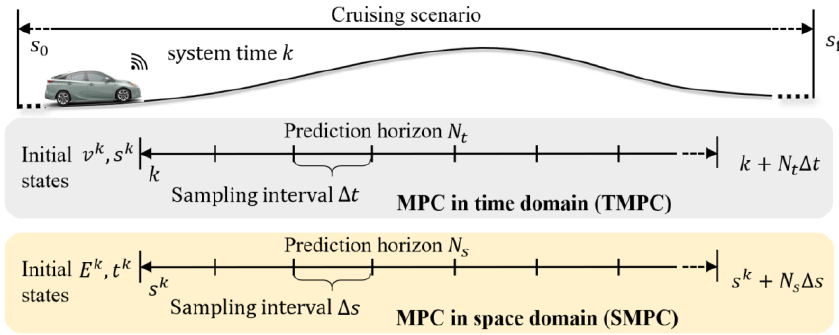
Figure 5. Comparison between TMPC and SMPC.